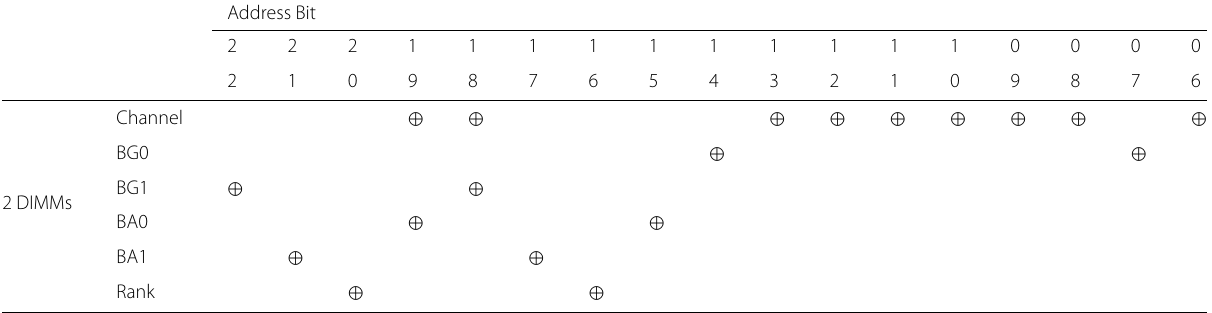
Table 1 Reverse-engineered DRAM mapping functions using the method from Pessl et al.